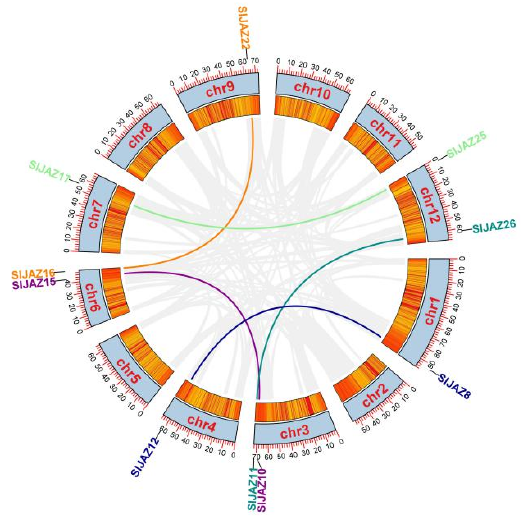
Figure 5. SlJAZ gene duplication events. The inner circle shows the distribution of genes on each chromosome. The gene names for each pair of duplication events are displayed in the same color.